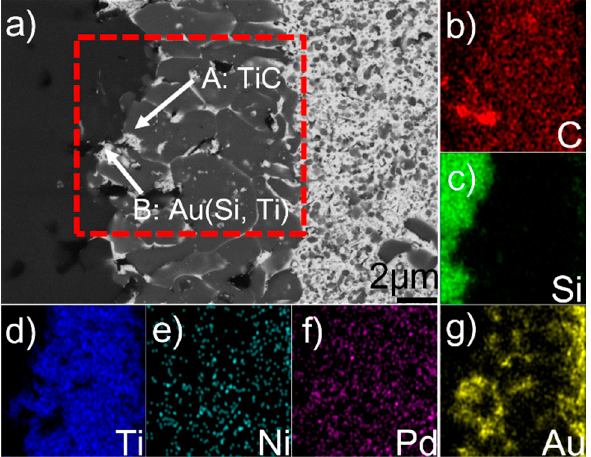
Figure 2. ( a ) BSE micrograph showing the detailed microstructure of the SiC/braze interface, and relevant elemental distribution maps of the red rectangle in ( a ): ( b ) C; ( c ) Si; ( d ) Ti; ( e ) Ni; ( f ) Pd; ( g ) Au. Table 1. Energy-dispersive X-ray spectroscopy (EDS) results of phases in the SiC/SiC joint. C Si Ti